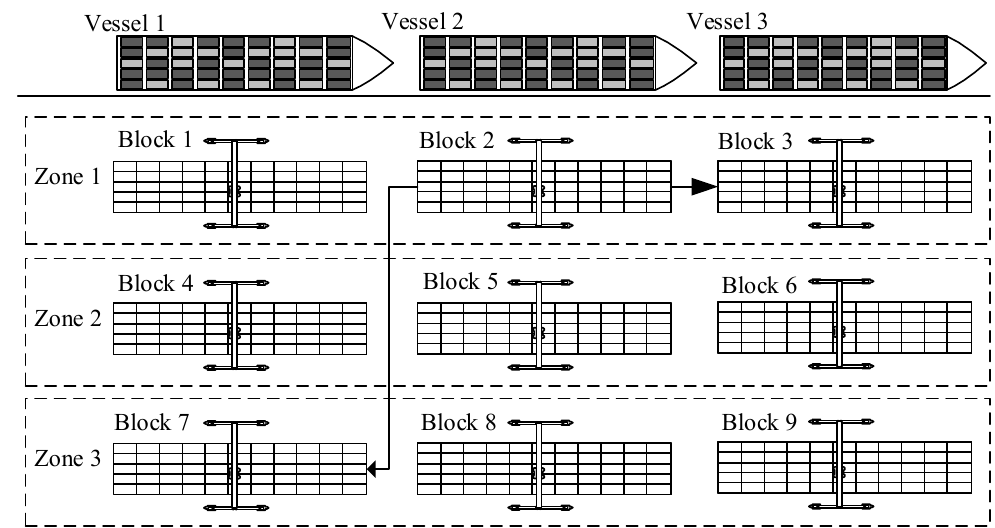
Figure 3. The layout of a typical container